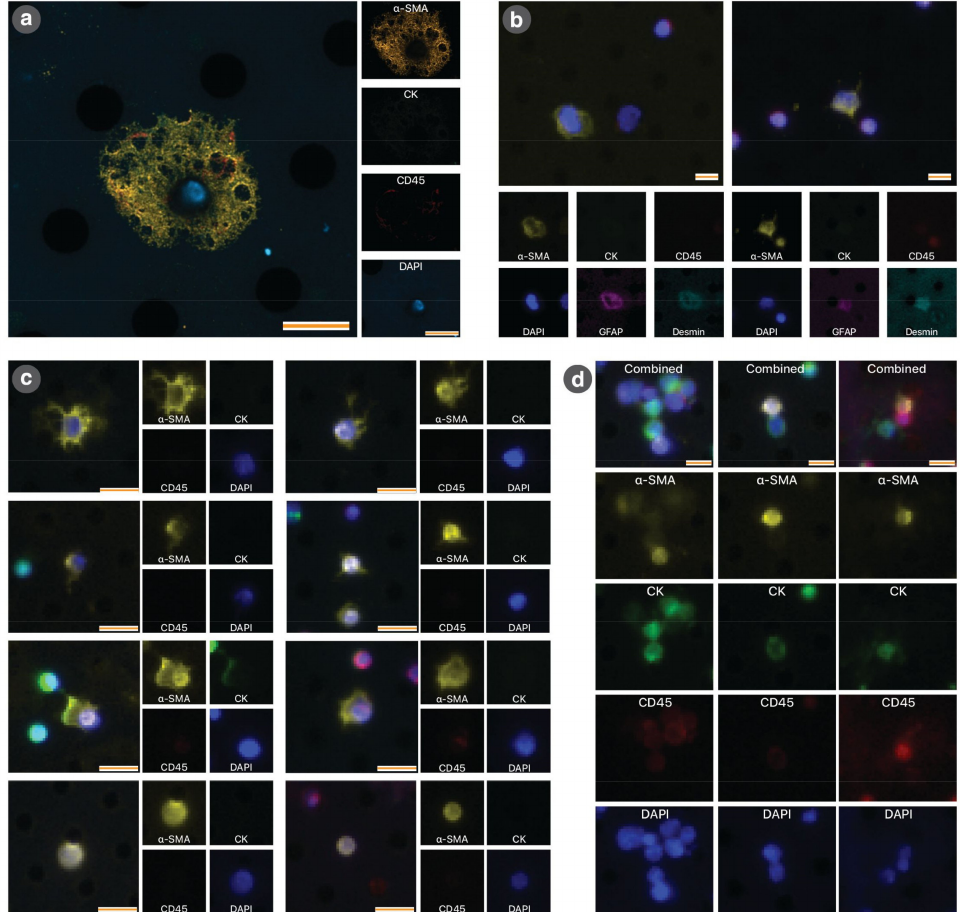
Figure 3. Immunocytochemical characteristics of circulating pancreatic stellate cells. ( a ) High- powered confocal microscopy image of cPSCs. The cPSC depicted demonstrates ovoid mor- phology and positive staining for α -SMA and DAPI but negative staining for CK and CD45. Small images on right represent individual fluorescence imaging channels. ( b ) Representative images of cPSCs that have undergone quenching and re-staining, demonstrating CK − /CD45 − / α - SMA+/Desmin+/GFAP+/DAPI+. The larger image at the top is a combined four-channel image ( α -SMA/CK/CD45/DAPI). The smaller images at the bottom are pseudo-colour images of each channel, including images acquired after quenching and re-staining (GFAP and desmin). The left cPSC demonstrates an ovoid morphology whereas the right cPSC demonstrates a more spiculated morphology. Note the size difference between adjacent CD45+ staining leucocytes. ( c ) Representative images of the four major morphologies of cPSCs identified on wide field microscopy. Images taken using 10 × objective. There are two images for each morphology (arranged side to side). The smaller images represent the corresponding individual fluorescence imaging channels. The four morpholo- gies were: (i–ii) Stellate morphology (St): well defined cytoplasmic extensions creating a spiculated appearance. (iii–iv) Round morphology with cytoplasmic extensions (CE): small round cells, with impressions of cytoplasmic extensions. (v–vi) Ovoid (Ov): large cells with prominent cytoplasm without definite spicules. (vii–viii) Round and bland morphology (RB): round cytoplasm without any evidence of extensions. ( d ) Three examples of heterotypic clusters containing cPSCs. Scale bars for all images: 10 µ